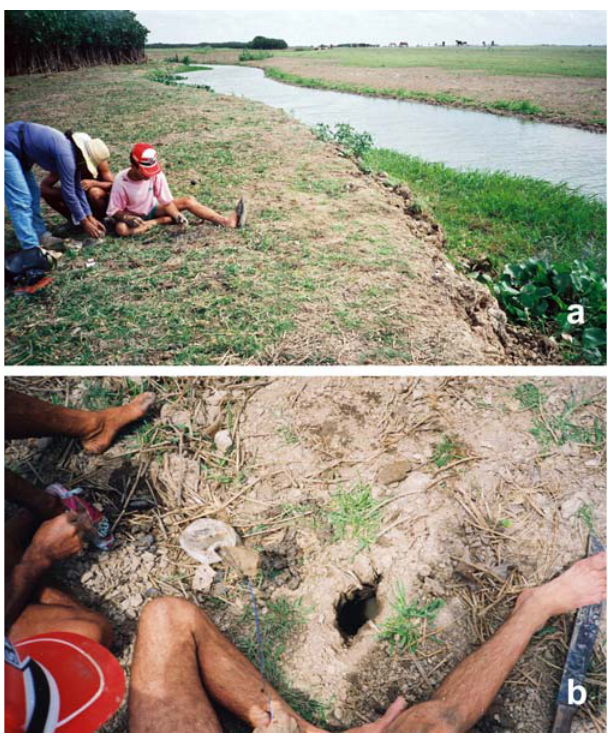
Fig. 4 . Type locality of Synbranchus lampreia . (a) rio Goiapi and collecting site, and (b) burrow containing